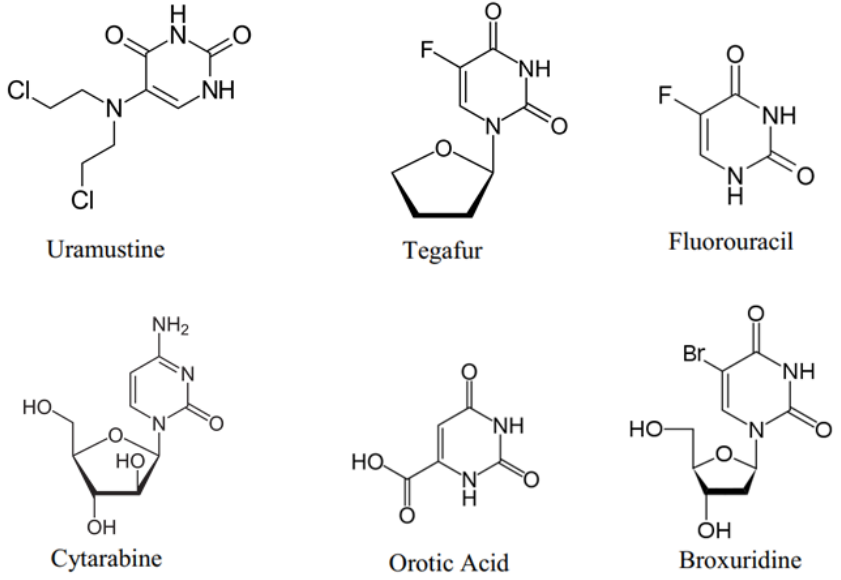
Figure 1. Chemical structures of some biologically and pharmacologically active